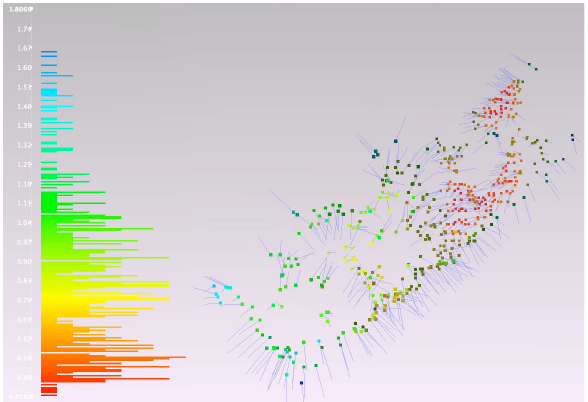
(figure 8). Some misclassified terrain points remain (red points, figure 8) after the density segmentation and removal of